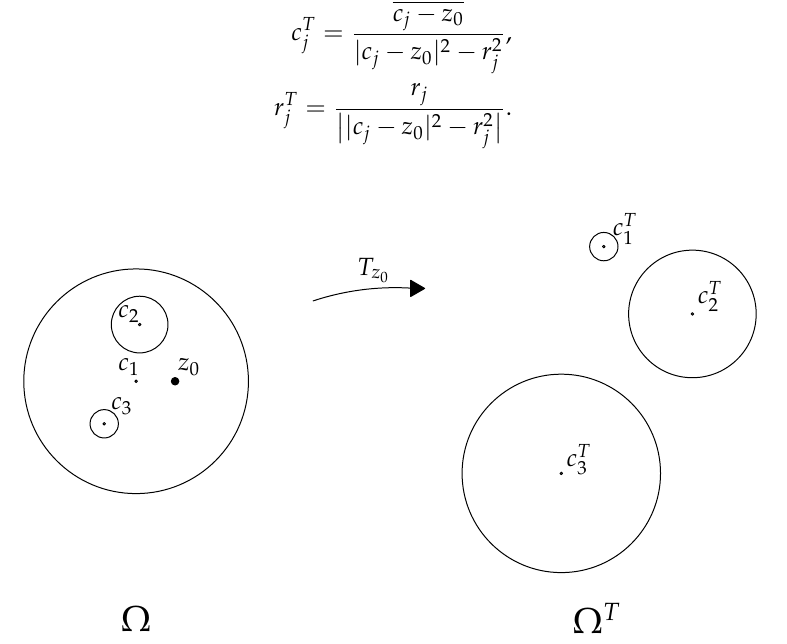
Figure 2. Mapping of the sphere world Ω by T z